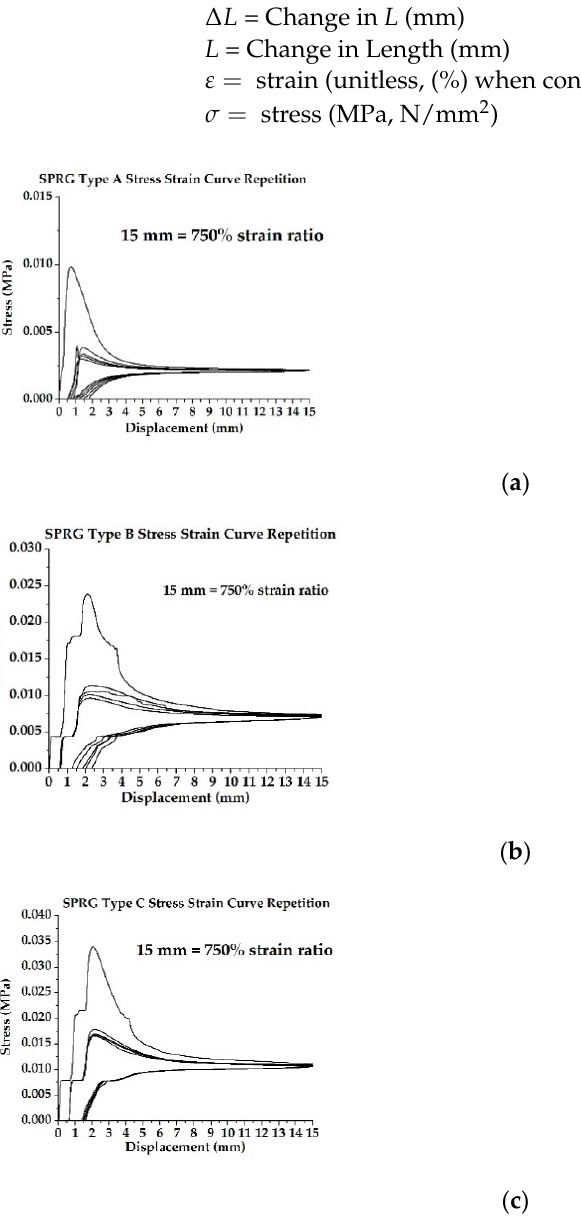
Figure 8. Stress-strain (via load vs. displacement) results from repeated tensile stress application (sample) ( a ) SPRG Type A Stress strain curve repetition and toughness calculation process, ( b ) SPRG Type B Stress strain curve repetition and toughness calculation process, ( c ) SPRG Type C Stress strain curve repetition and toughness calculation process. Refer to Table 7 below for results on toughness calculation results based on the re- peated tensile stress testing.